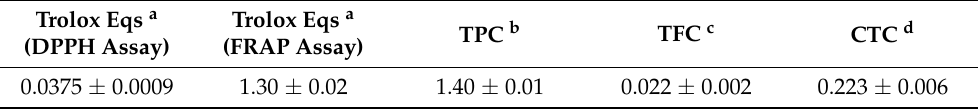
Table 1. Antioxidant properties and phenolic content of FSE. Reported are the mean ± SD values of at least three